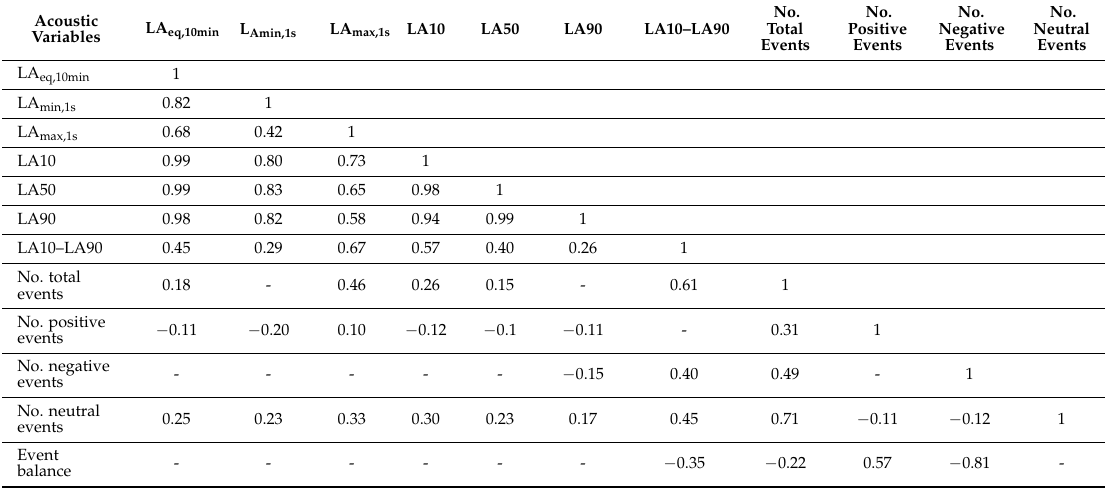
Table 5. Pearson correlations (1) between acoustic variables ( n =